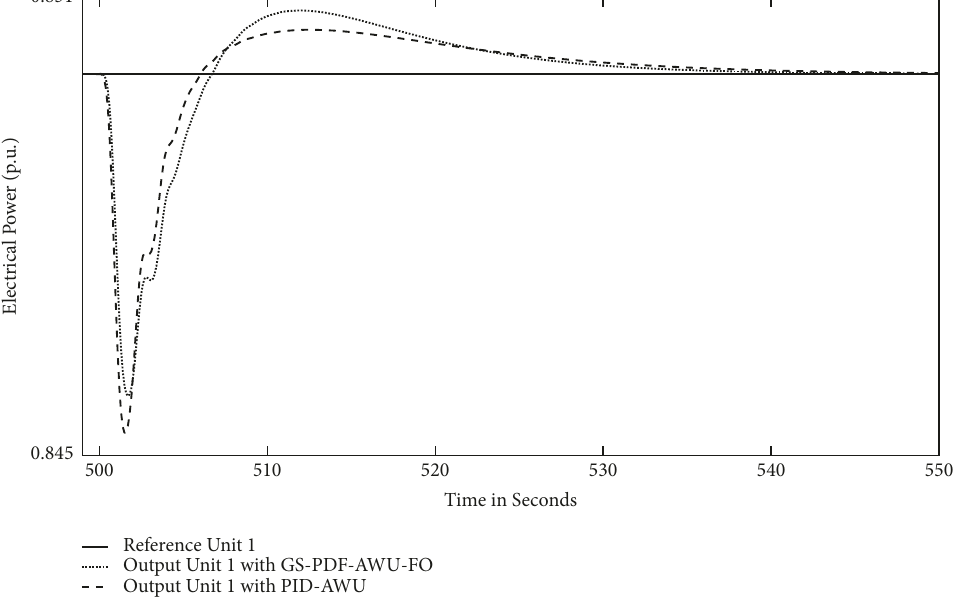
For both groups of simulation, one and six operational units, with different values of the hydraulic head (h=1 and h=0.9), ITAE indexes were calculated. For all cases, this index is lower when the system is controlled by the GS-PDF-AWU- FO rather than PID-AWU (Figure